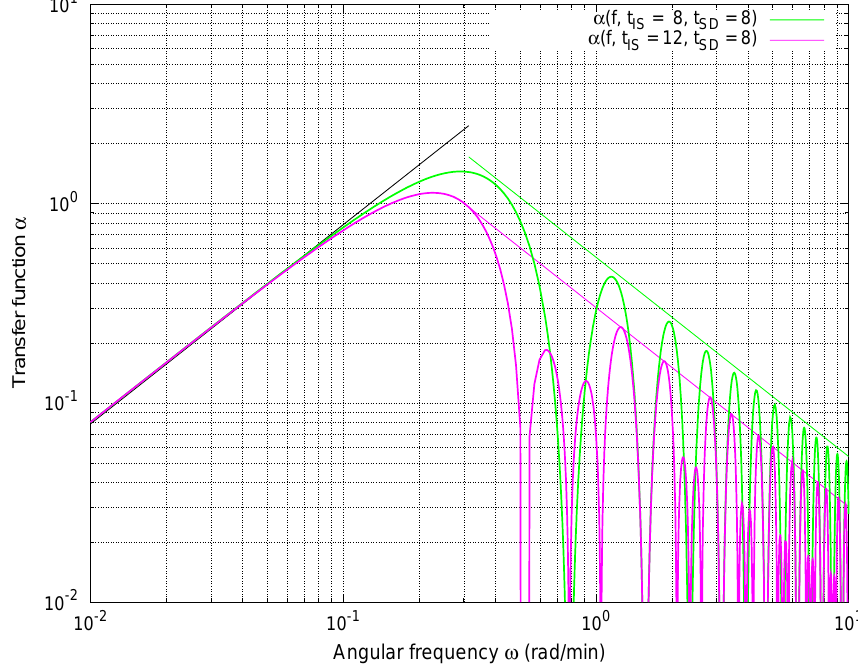
Fig. 3a. Transfer function α(ω) given in Eq. (3c) for the function M(t) for two different values of t IS (6min and 8min) and for t SD = 8min. The transfer function decays as 6dB per octave towards both high (see the envelope) and low frequencies. In the shown examples, the passing band covers the periods approximately between 15 and